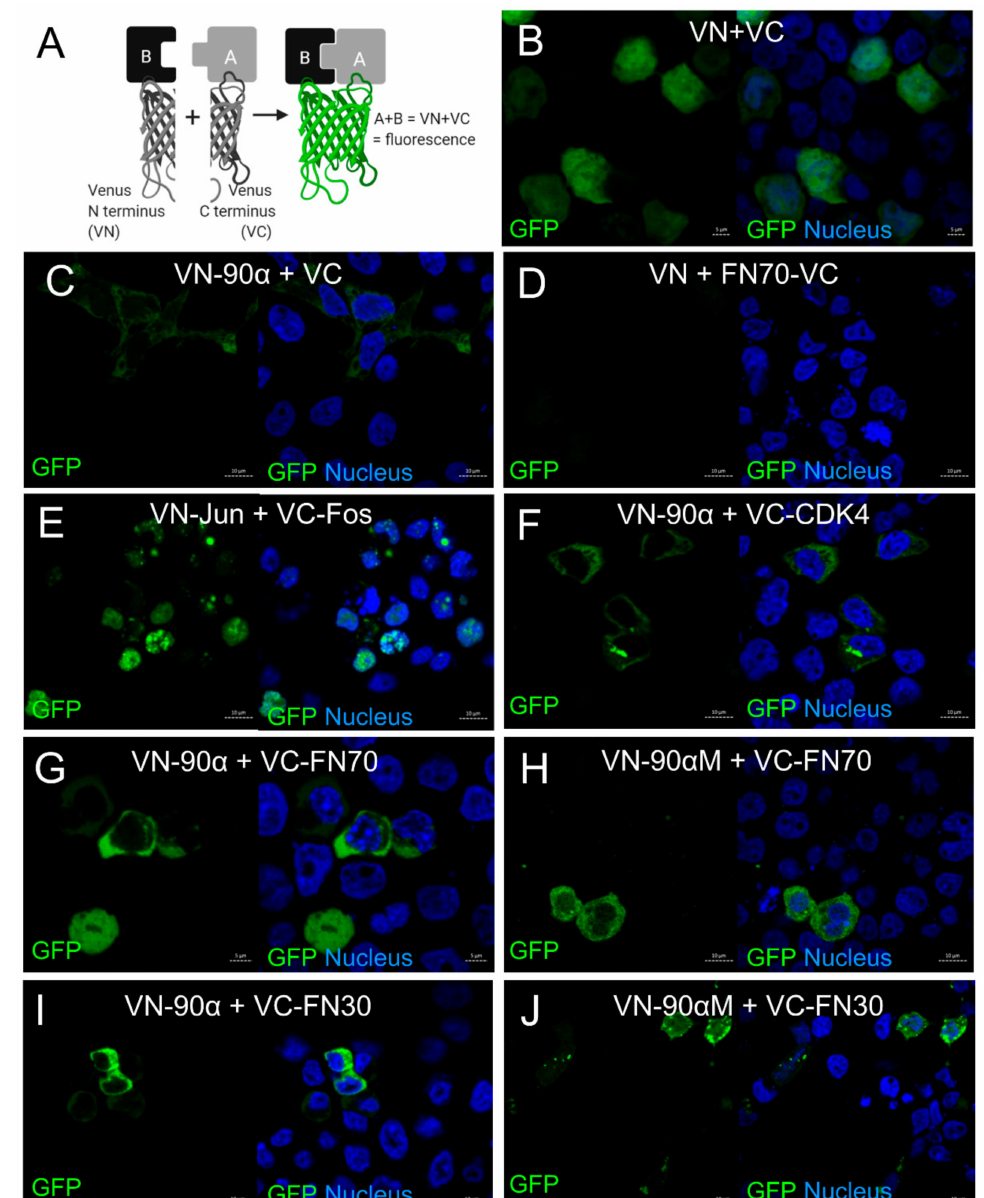
Figure 4. HSP90 and fibronectin interact directly in cells. Biomolecular complementation (BiFC) assay using split mVenus tagged FN and HSP90 proteins in HEK293T cells. ( A ) Schematic diagram of the BiFc method for measuring protein–protein interactions in cells. Images shown co-transfection of ( B ) empty vectors pBiFC-VN173 (VN) and pBiFC-VC155 (VC) (negative control), ( C ) pBiFC-VN173-HSP90 α (VN-90 α ) and VC (negative control), ( D ) pBiFC-VC155-FN70 (FN70-VC) and VN (negative control), ( E ) pBiFc-VN173-bJun (VN-Jun) and pBiFC-VC155-delbFos (VC-Fos) (positive control), ( F ) VN-90 α and pBiFc-VC155-CDK4, ( G ) VN-90 α and VC-FN70, ( H ) pBiFc-VN173-90 α M domain (VN-90 α M) and VC-FN70, ( I ) VN-90 α and VC-FN30, and ( J ) VN-90 α M and VC-FN30. In all cases, endogenous fluorescent signal (GFP; green) was captured by confocal microscopy using the EGFP filter set. Scale bars are equivalent to 5 or 10 µ m and data shown are representative of biological triplicate